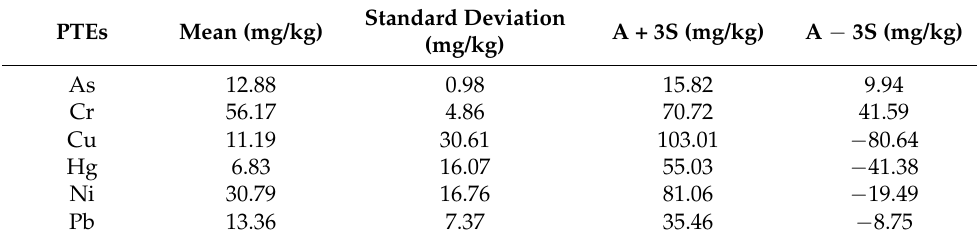
Table 5. Mean, standard deviation, and upper and lower bounds of abnormal values for six PTEs.